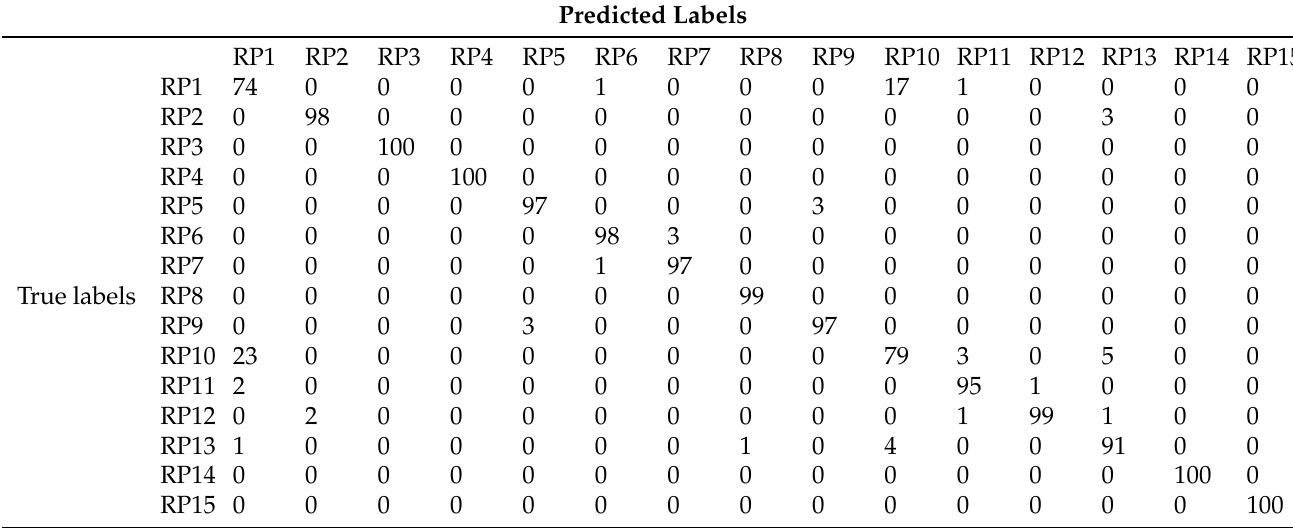
Table 8. Specific reference point confusion matrix of the proposed CWT Images with data augmentation using CNN.